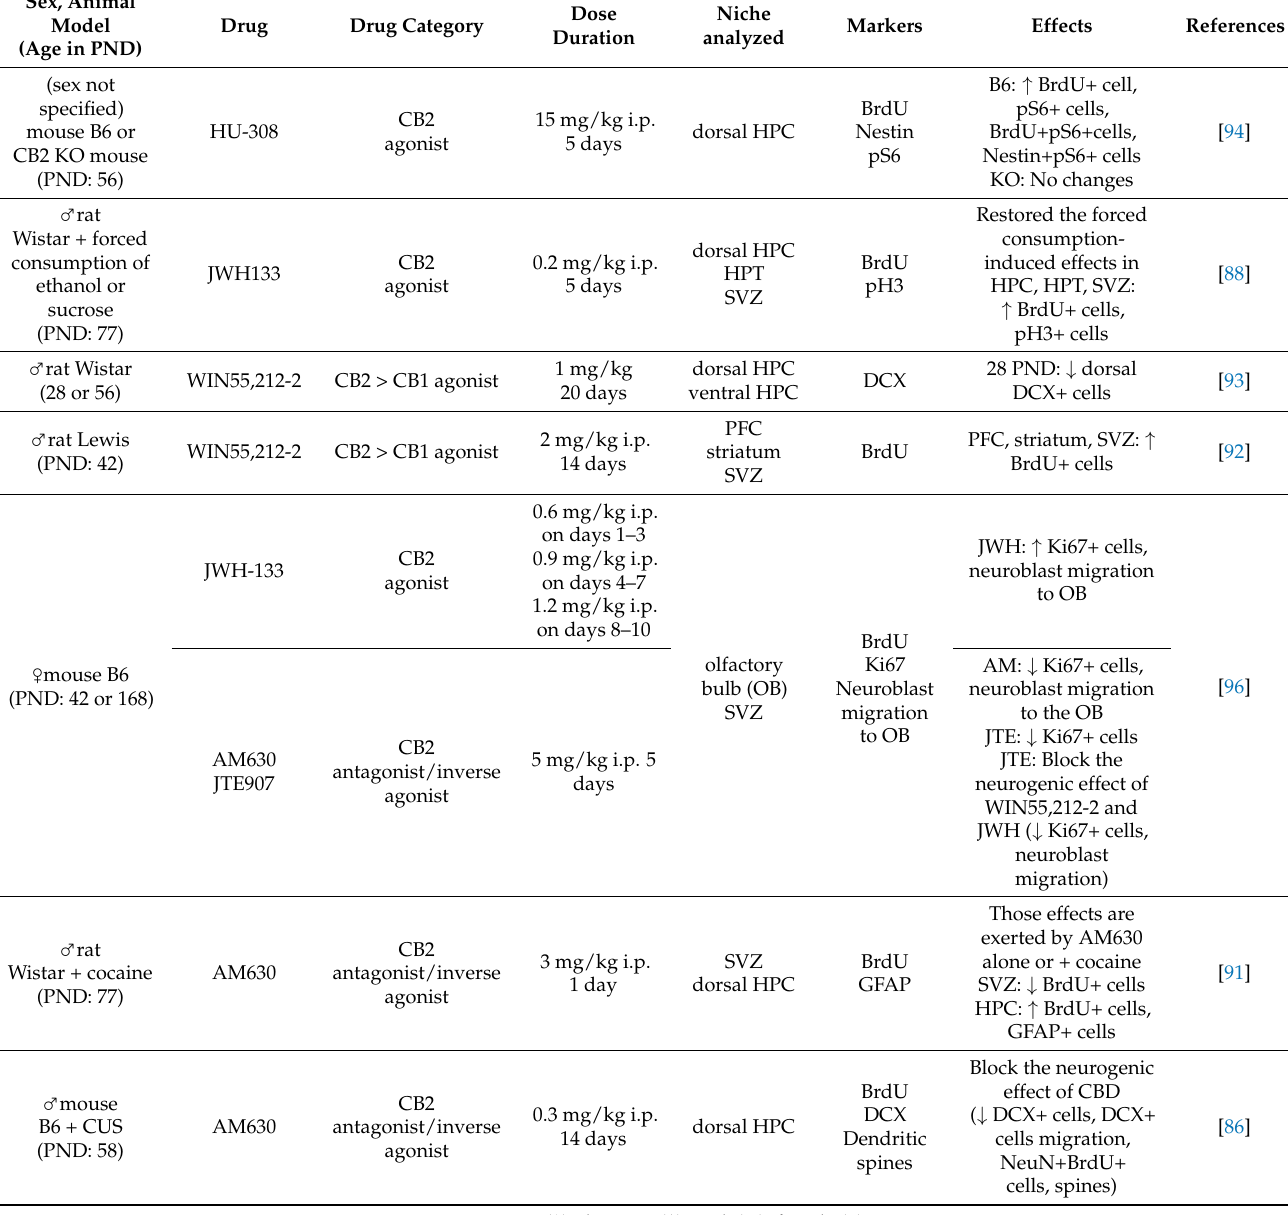
Table 5. Effects of CB2 modulation on